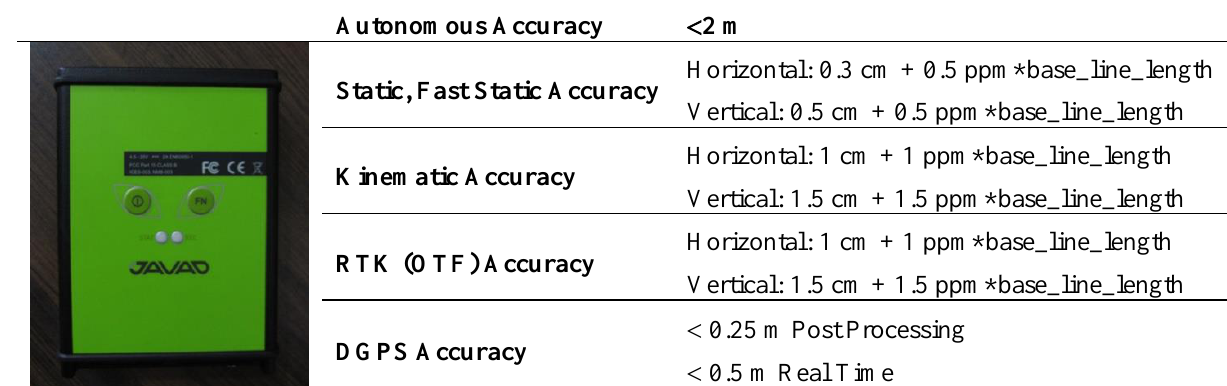
Table 10. The specifications for the position reference system